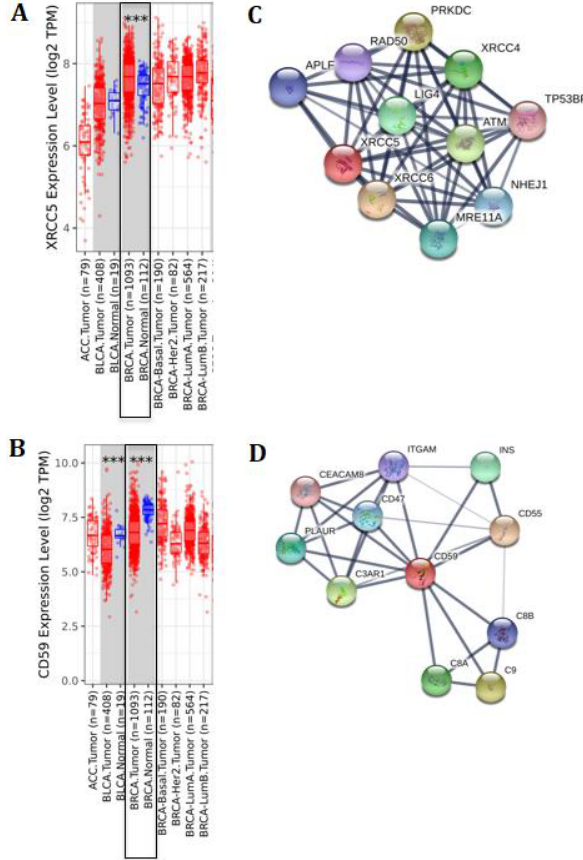
Figure 2. Gene expression of (A) XRCC5 and (B) CD59 across different breast cancer samples from TCGA study, as analyzed by TIMER. Statistical significance was calculated using the Wilcoxon test. * or ** or *** indicate p < 0.05 or p < 0.01 or p < 0.001, respectively. Protein–protein interaction networks related to (C) XRCC5 and (D) CD59, as analyzed by